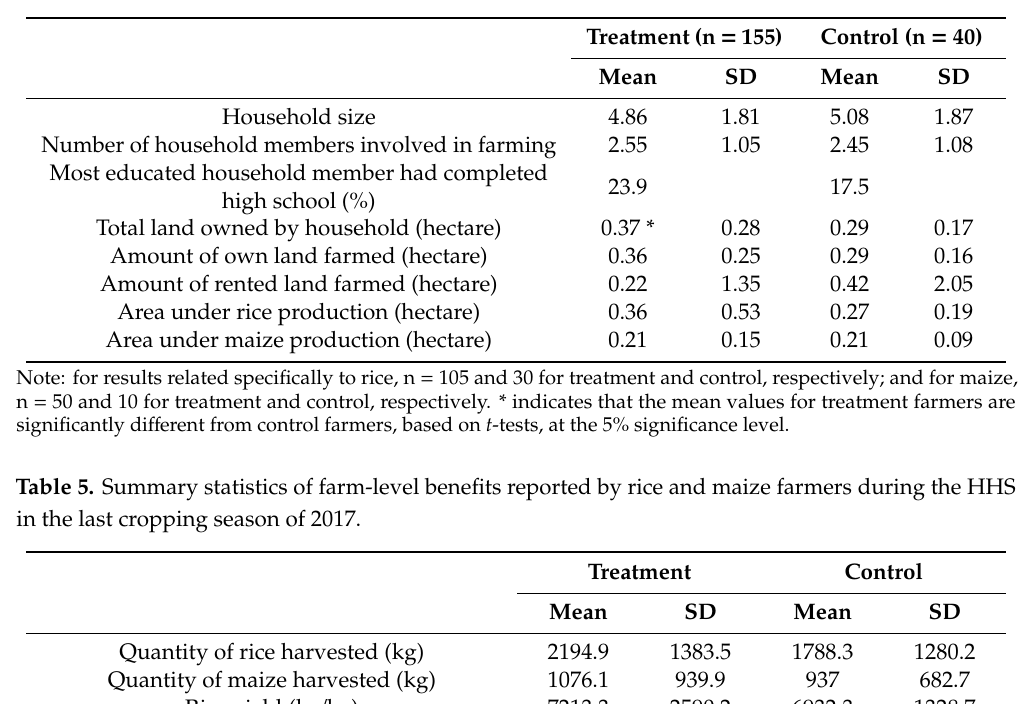
Table 4. Socio-economic characteristics of the sampled farmers during the Householder Questionnaire Survey (HHS).